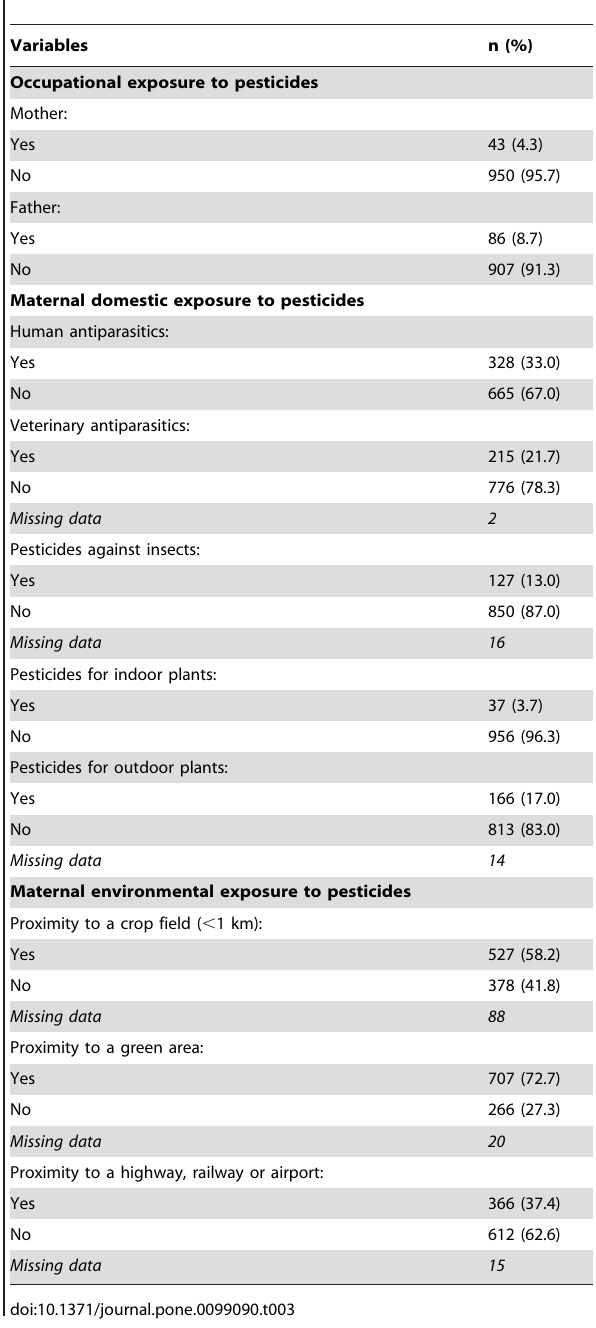
Table 4. Characteristics of prenatal exposure to pesticides (n=993)